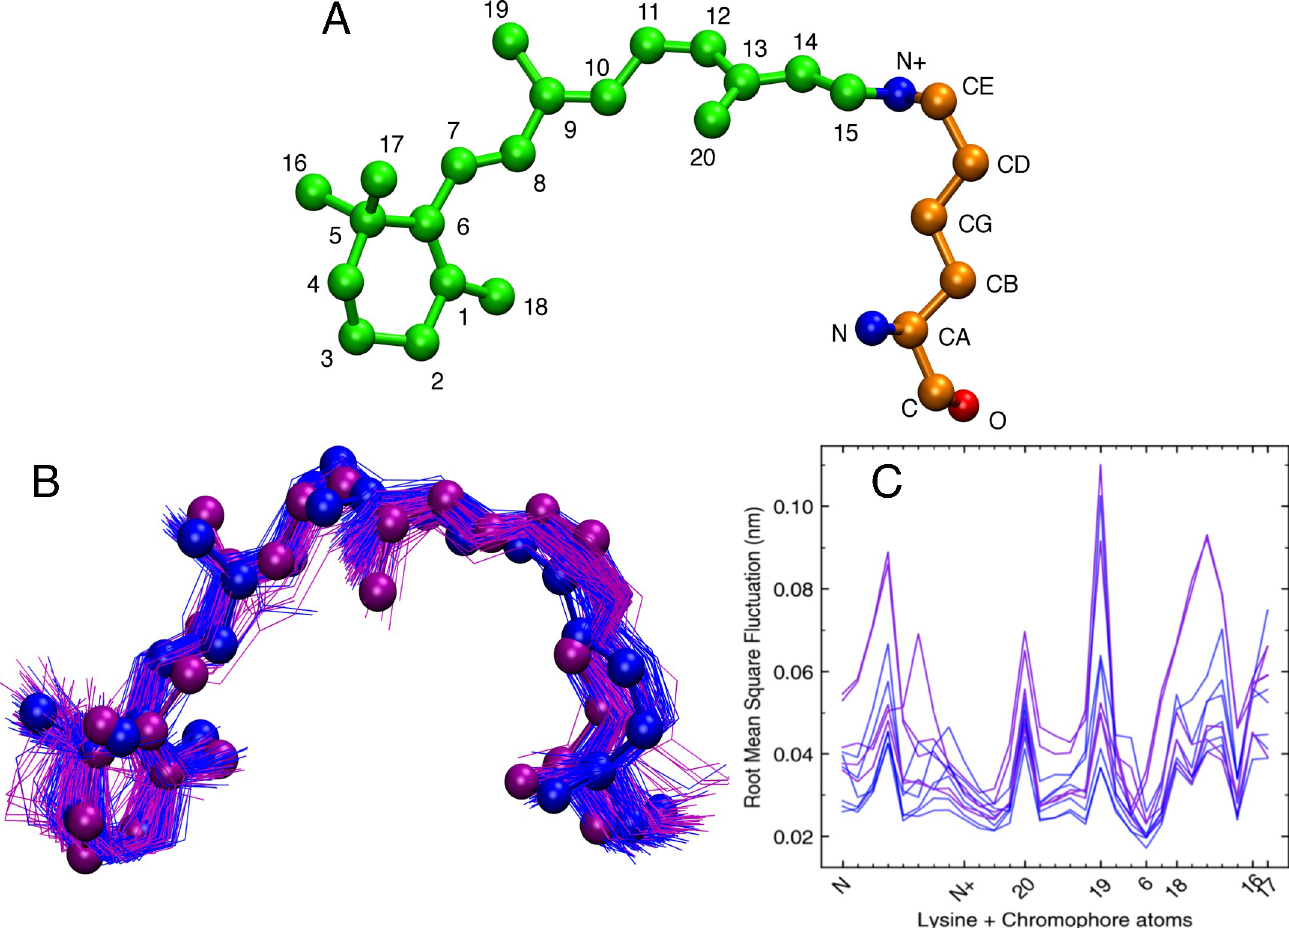
Fig 3. Conformations and fluctuations of 11- cis retinal chromophore and attached lysine in Sws2 photopigments. A) 3D orientation of 11- cis retinal linked to K296 of the opsin protein. B) Superposition of 11- cis retinal conformations from MD simulations trajectories. C) Root mean square fluctuation (RMSF) of 11- cis retinal linked to K296 (LYS+RET). The horizontal axis represents atoms of the LYS+RET. Blue- vs. violet-colored ball-and-stick conformations are those associated with Sws2 photopigments with λ max values > 430 nm vs. λ max values < 430 nm, respectively.